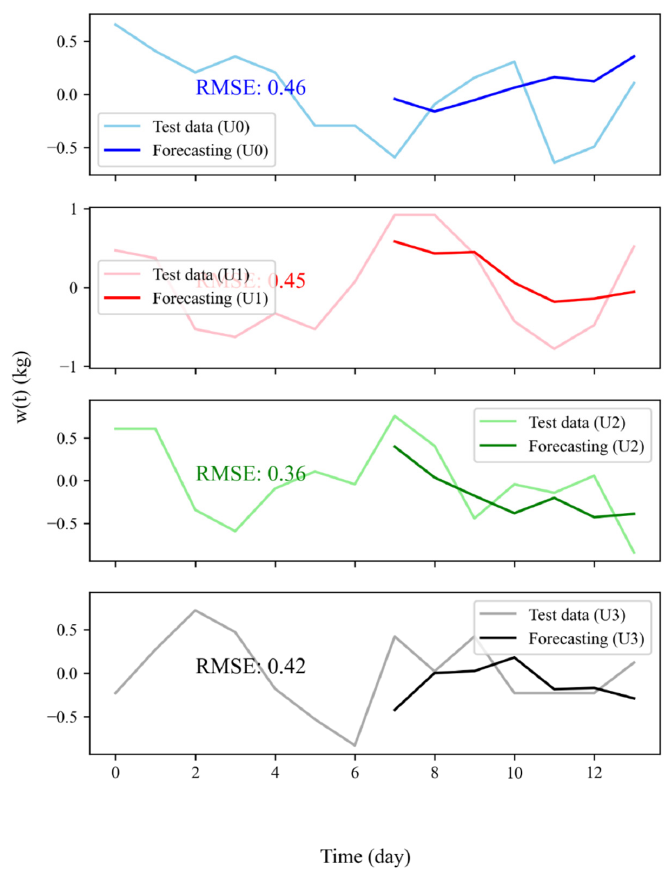
Figure 3. Test-train forecasting for all users (U0, U1, U2 and U3) with the relative root mean squared value.